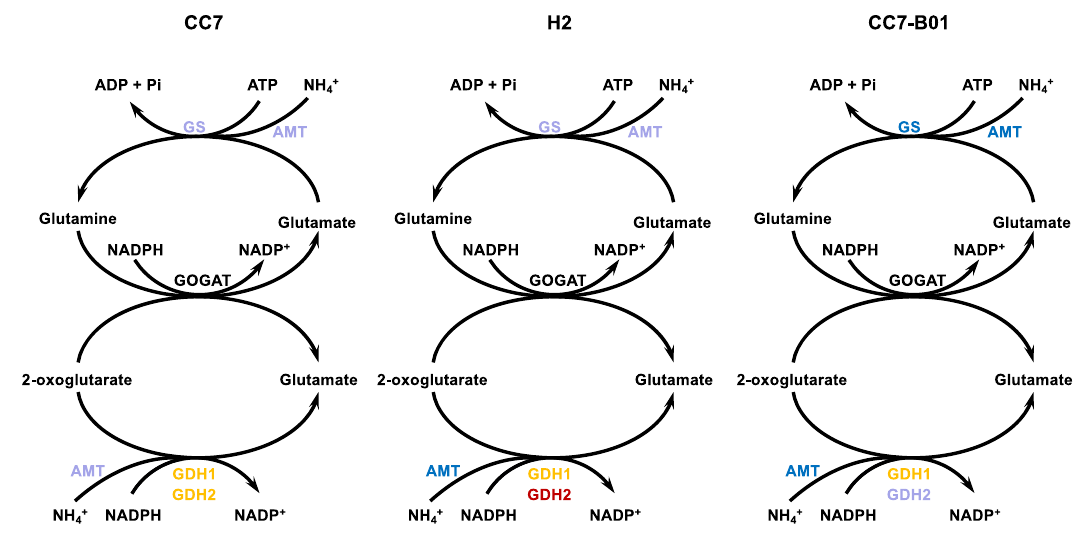
Fig. 5 Ammonium assimilation pathway expression changes after heat stress in CC7, H2, and CC7-B01. The most signi fi cant response changes were observed in CC7-B01, where most genes were signi fi cantly down-regulated (when they were expected to be up-regulated in a stable symbiosis). GS glutamine synthetase, AMT ammonium transporter, GOGAT glutamate synthase (was not detected in transcriptomes), GDH glutamate dehydrogenase. Colour code shows light purple – down-regulated, dark blue – signi fi cantly down-regulated, yellow – up-regulated, red – signi fi cantly